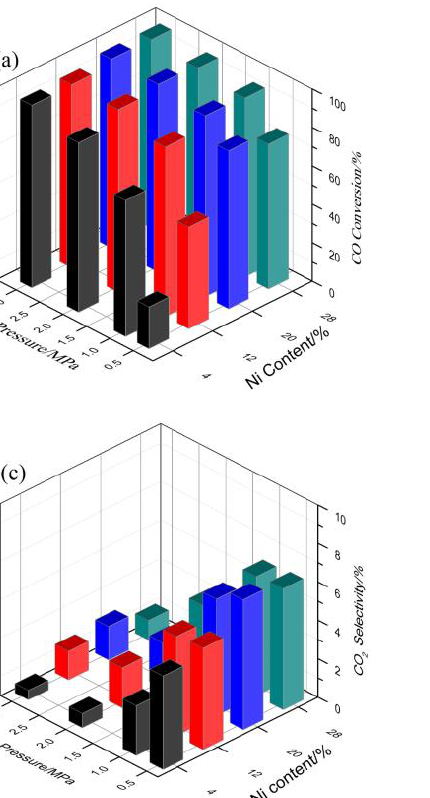
Figure 3. Effect of reaction pressure on catalytic performance for CO methanation over x Ni/MCM- 41 catalysts. ( a ) CO conversion, ( b ) CH 4 selectivity, ( c ) CO 2 selectivity, ( d ) C 2–4 selectivity. Black: 4Ni/MCM-41, red: 12Ni/MCM-41, blue: 20Ni/MCM-41, dark cyan: 28Ni/MCM-41.